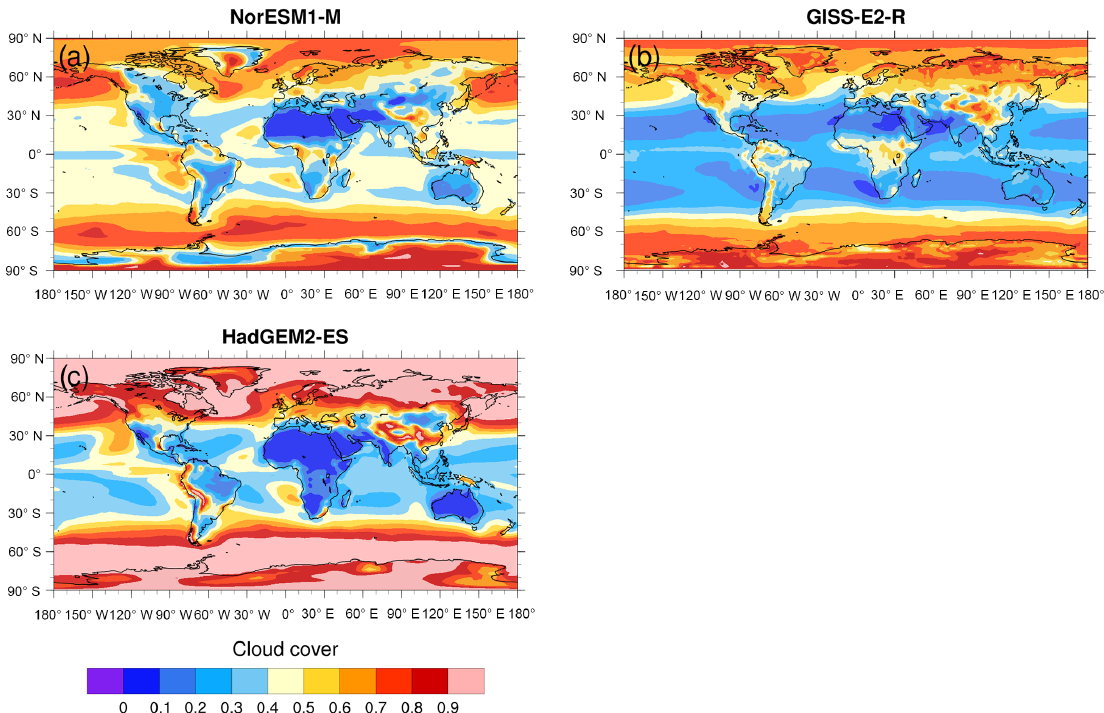
Figure 2. Cloud fraction for low clouds averaged over 2020–2030 within the RCP4.5 scenario for (a) NorESM1-M, (b) GISS-E2-R, and (c) HadGEM2-ES. Cloud fractions have been estimated by assuming random overlapping for layers below 850hPa (a, c) and below 600hPa (b)